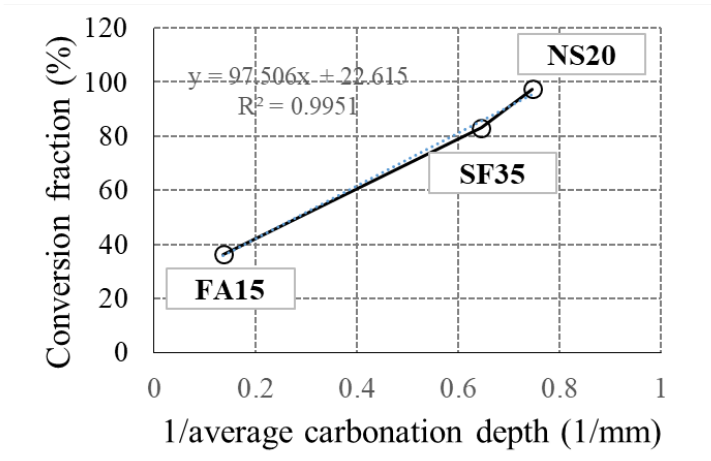
Figure 11. Relationship between conversion fraction and carbonation depth.